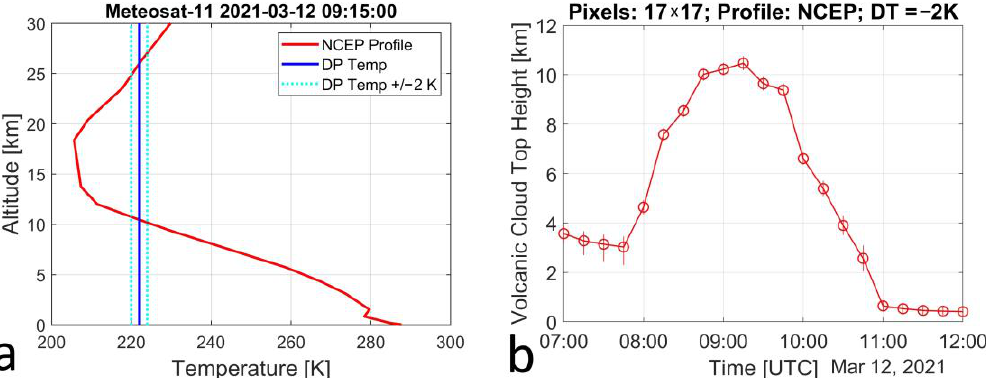
Figure 2. ( a ) Darkest Pixel (DP) procedure applied on the 12 March 2021, 09:25 UTC SEVIRI image. ( b ) The complete Volcanic Cloud Top Height (VCTH DP ) time series obtained for the 12 March 2021 Etna lava fountain.